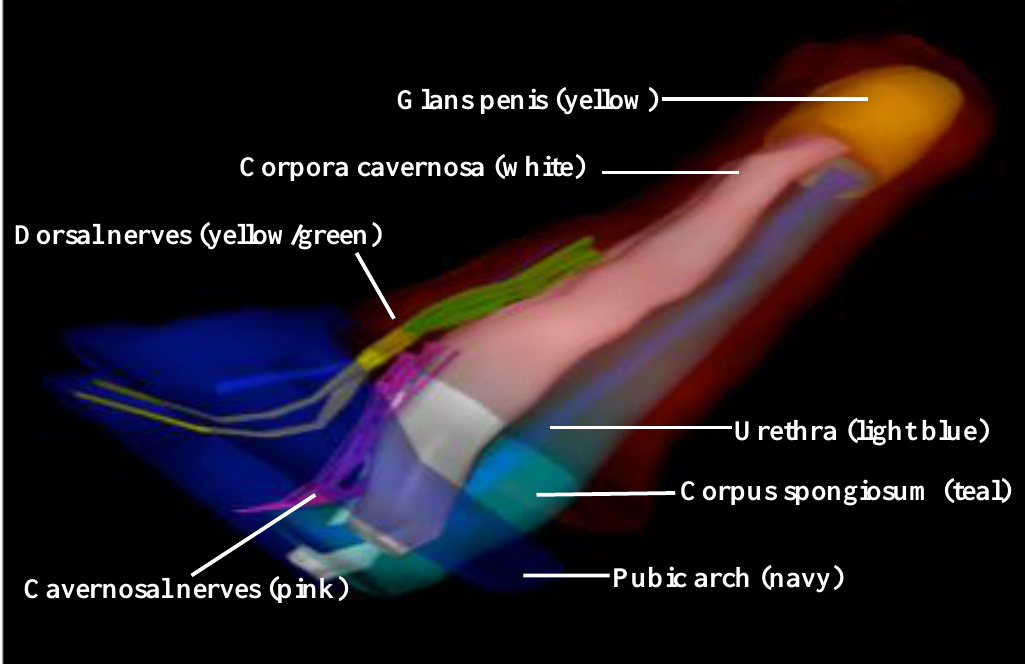
FIGURE 4. Dorsal-lateral view: 3-dimensional reconstruction of penile